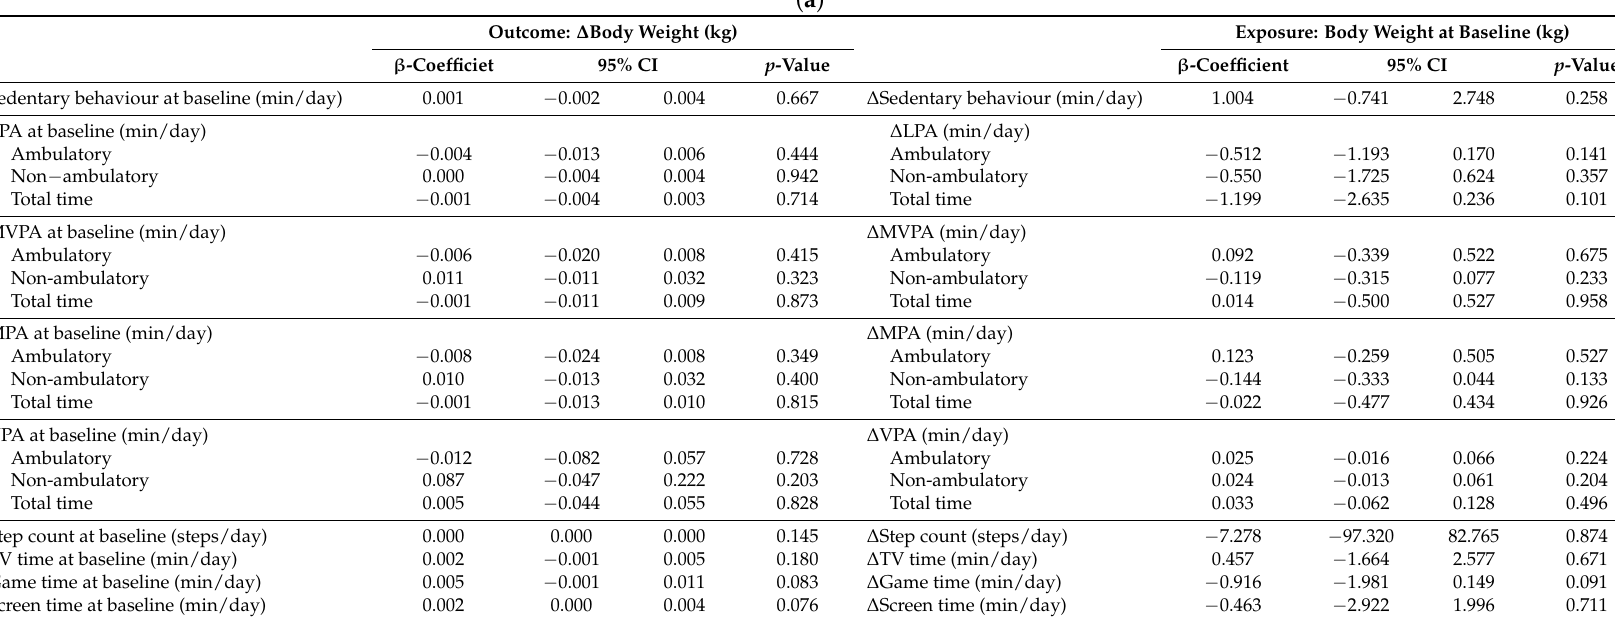
Table 2. (a) Baseline sedentary behaviour and physical activity as predictors of change in body weight and vice versa; ( b ) Baseline sedentary behaviour and physical activity as predictors of change in relative body weight and vice